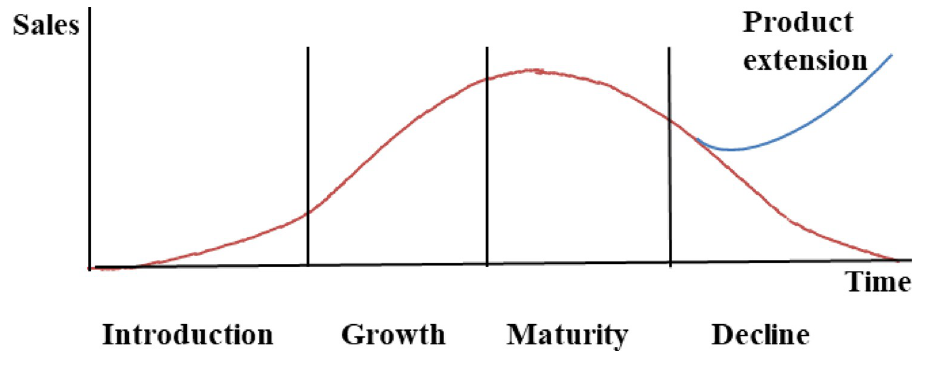
Fig 1. Product life cycle